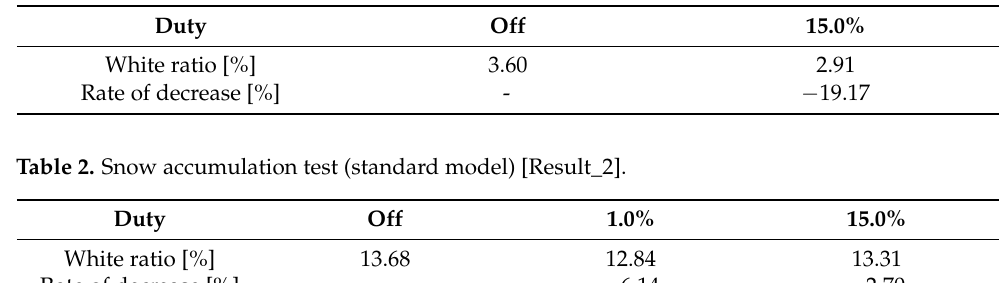
Figure 27. Snow accumulation test (standard model) [Result_2]. Table 1. Snow accumulation test (standard model) [Result_1].